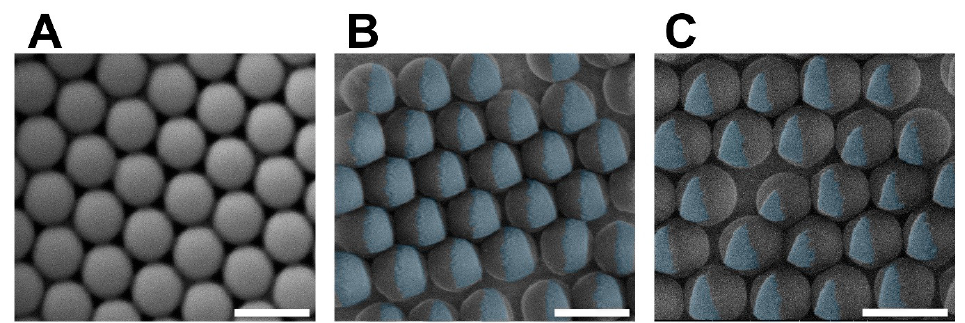
Figure 1. SEM images of a monolayer of PS spheres: ( A ) before silica deposition and after silica deposition at ( B ) 75° and ( C ) at 80°. The blue-coloured part shows the silica coated area. All scale bars are 500 nm.